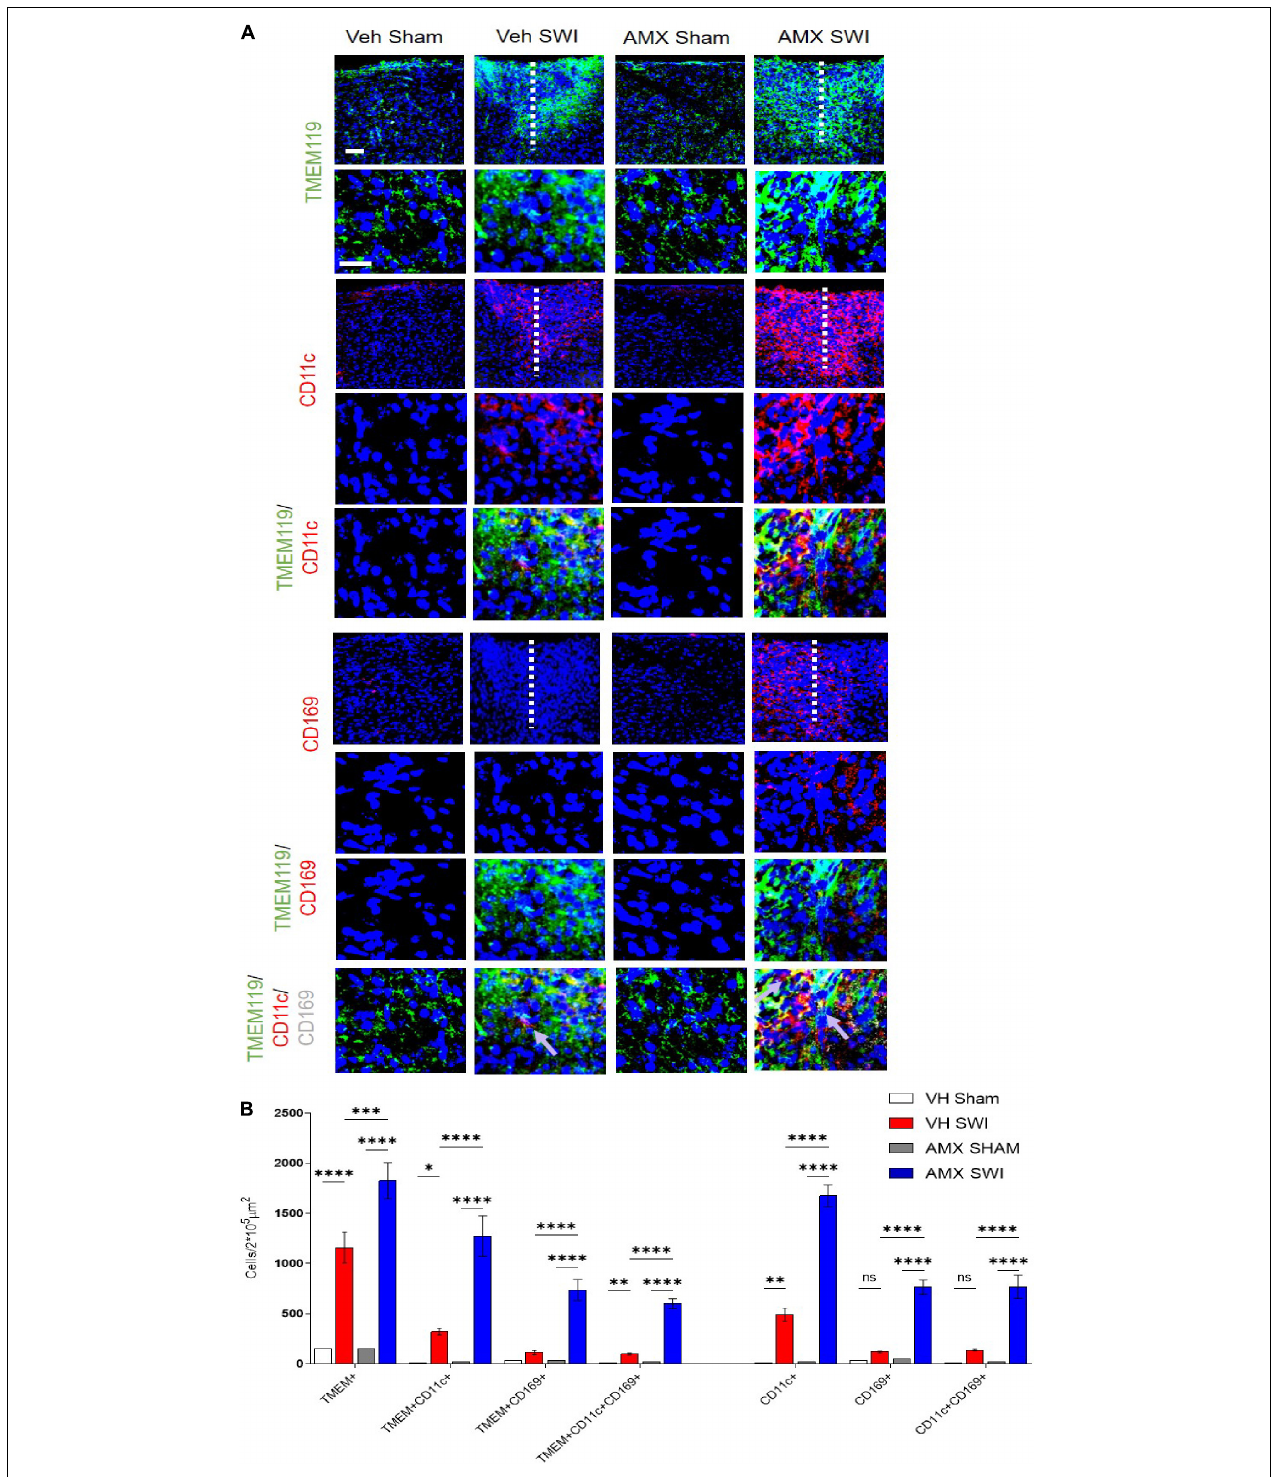
FIGURE 2 | Tbk1 blockade enhances the induction of CD11c + and CD169 + microglia upon Stab Wound Injury (SWI). (A,B) AMX treatment caused the significant elevation in TMEM119 + microglial cells in the SWI injury site at 7 dpi. Co-immunostaining with makers of microglial subsets CD11c and CD169 revealed the massive expansion of CD11c + microglia (disease associated microglia; DAM) as well as reactive CD11c + /CD169 + microglia. ( n = 3 animals/group with 4 sections/animal. Average ± SD; one-way ANOVA with Tukey’s post hoc; ns: not significant, ∗ p < 0.05, ∗∗ p < 0.01, ∗∗∗ p < 0.001, ∗∗∗∗ p < 0.0001; full statistical analysis in Supplementary Table 4 ). Upper panel, low magnification; lower panel, high magnification. Scale bars (equal for both sets of panels) 200 µ m.